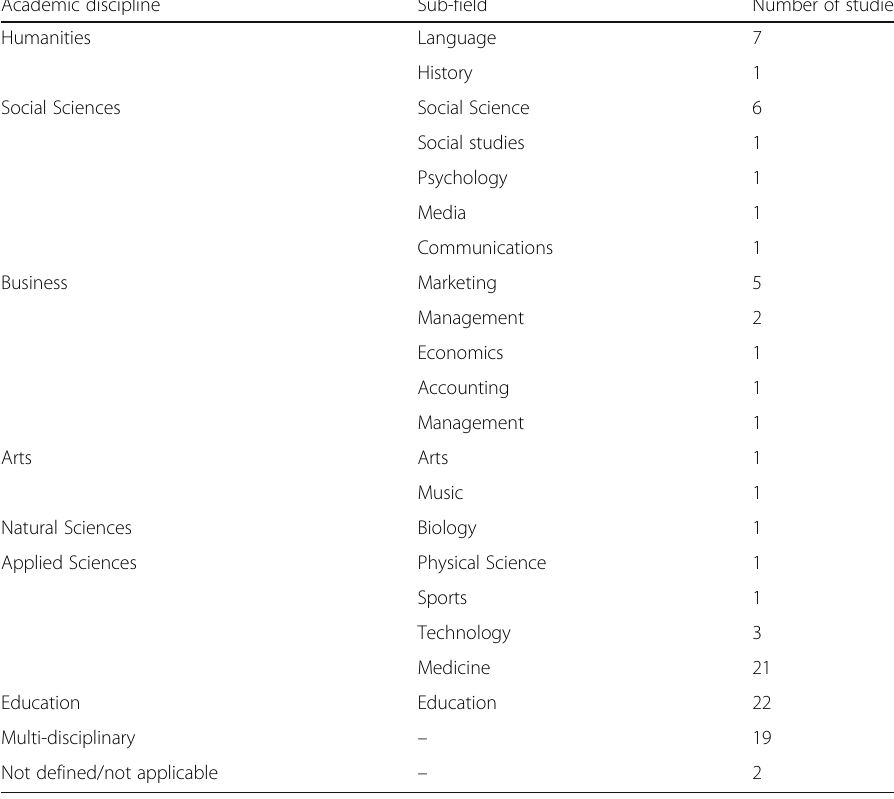
Table 5 Frequency of academic